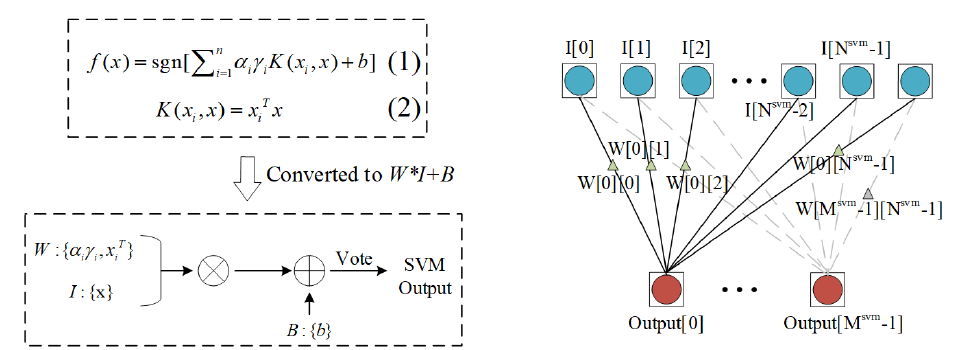
Figure 4. Convert decision function into matrix–vector